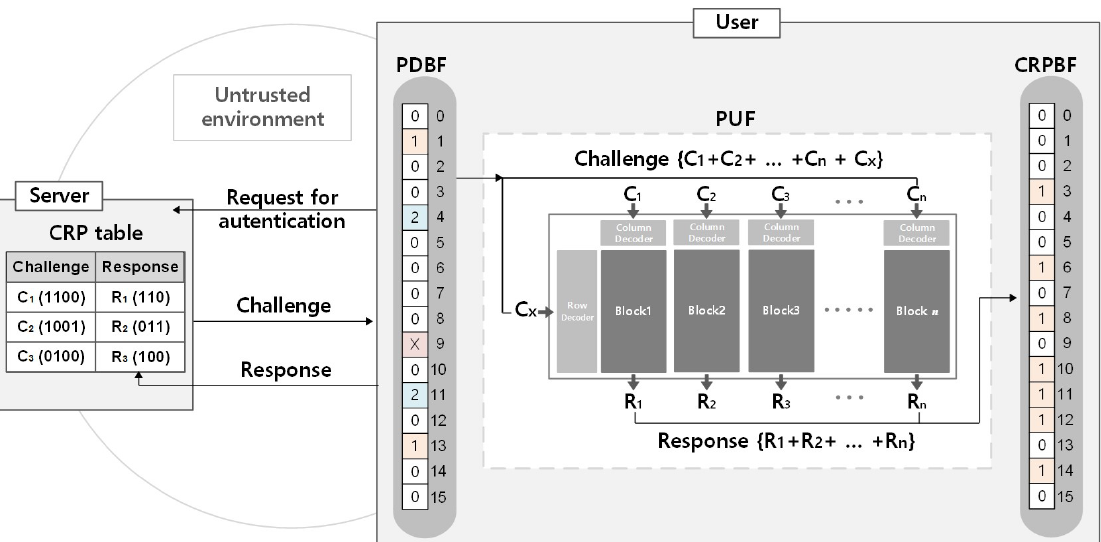
Figure 1. Proposed physical unclonable function database Bloom filter (PDBF) and challenge–response pair Bloom filter